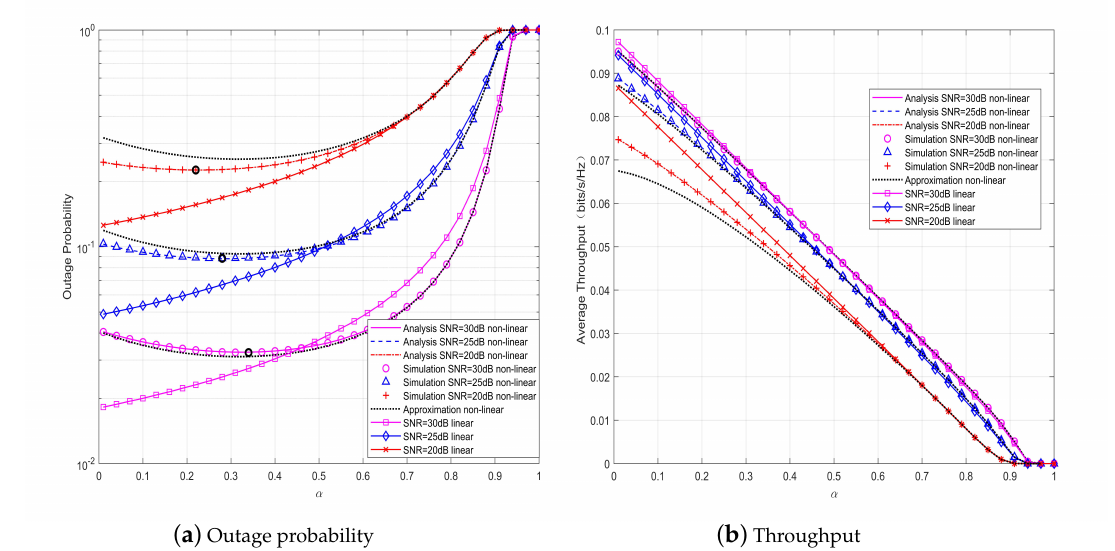
Figure 3. System performance versus α for various signal-to-noise ratios (SNR) when ρ = 0.5, d 1 = 2.2